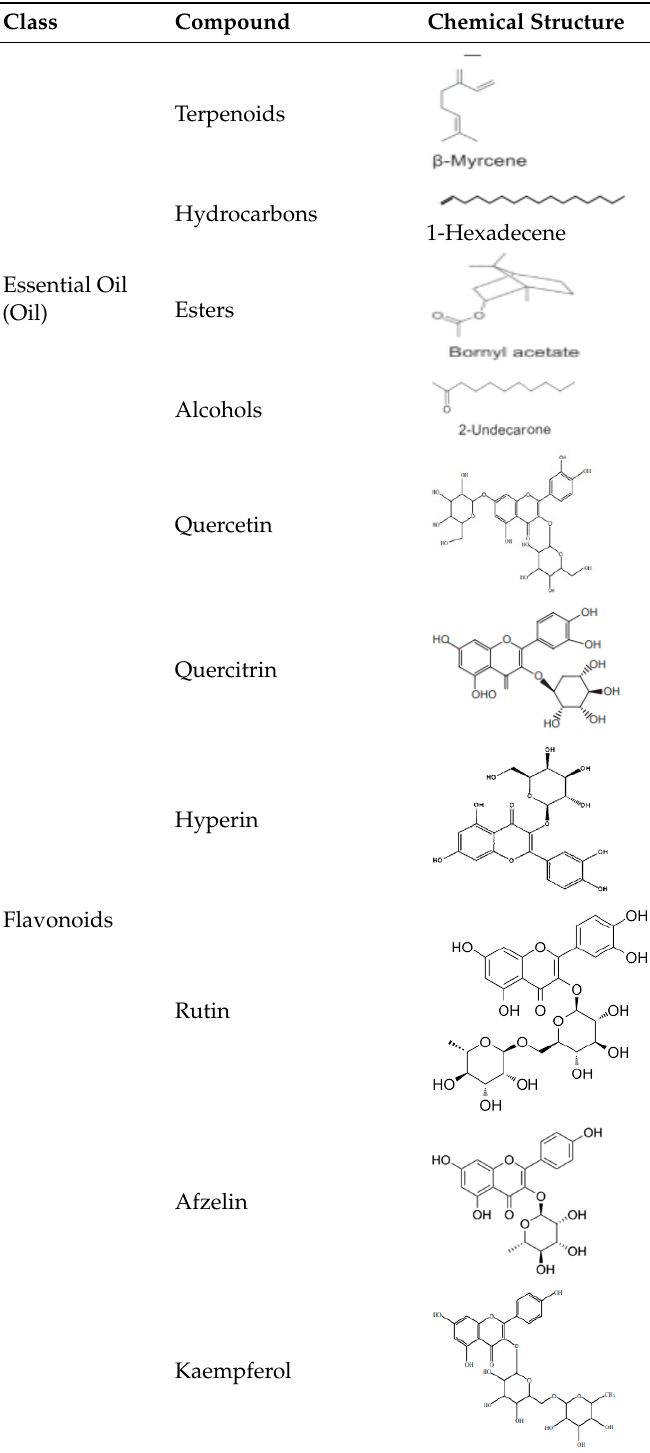
Table 1. Therapeutic effect of different extracts of H. cordata .